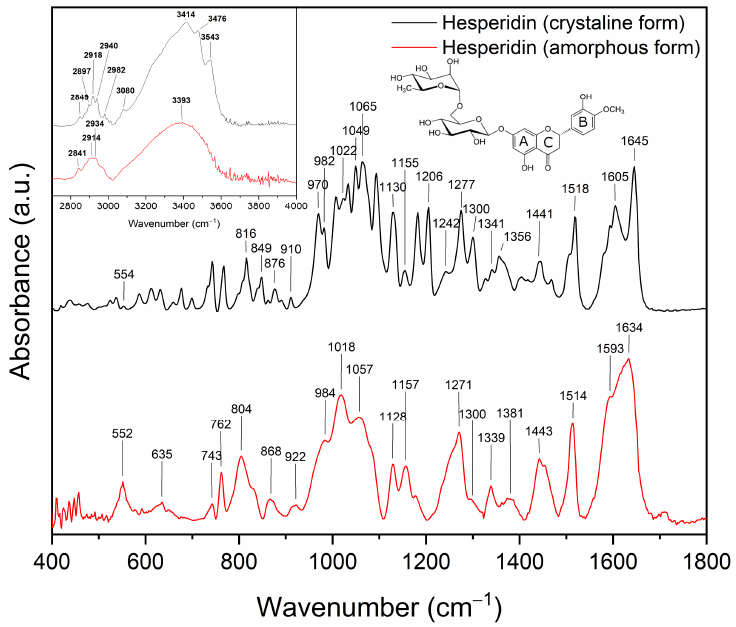
Figure 3. The FT-IR spectra: hesperidin crystalline form (black) and hesperidin amorphous form (red). Figure shows the structure of hesperidin with the positions of rings A, B and C marked.